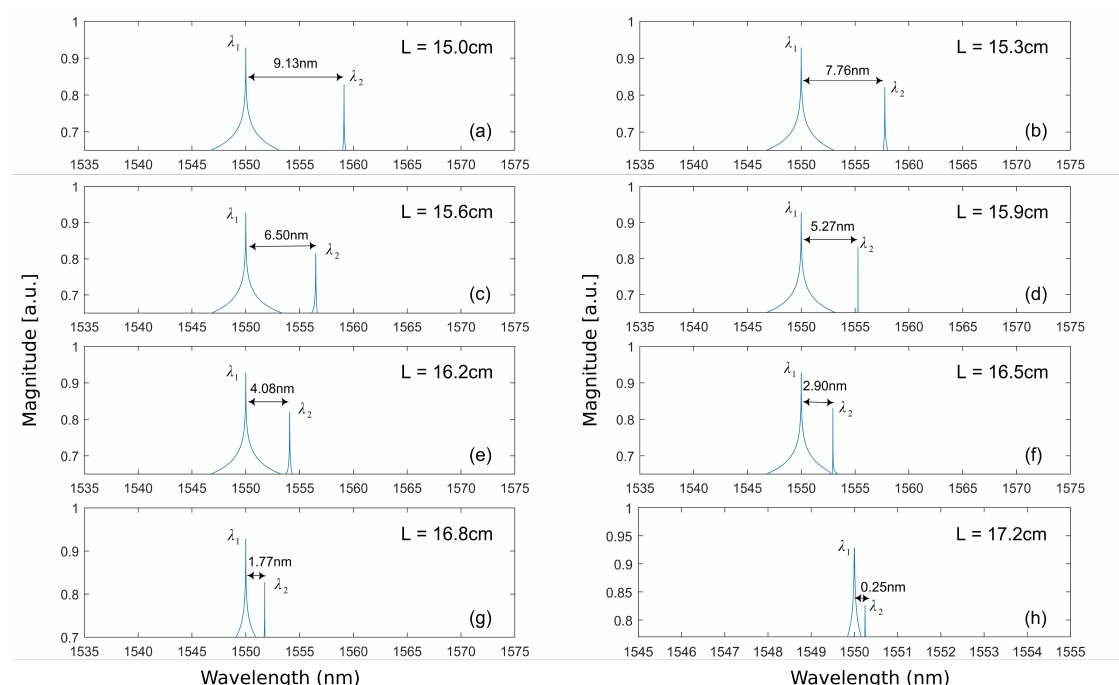
Figure4. Opticalspectrumofthedual-frequencylasersignals. ( a – h )withdi ff erentexternalcavitylength.